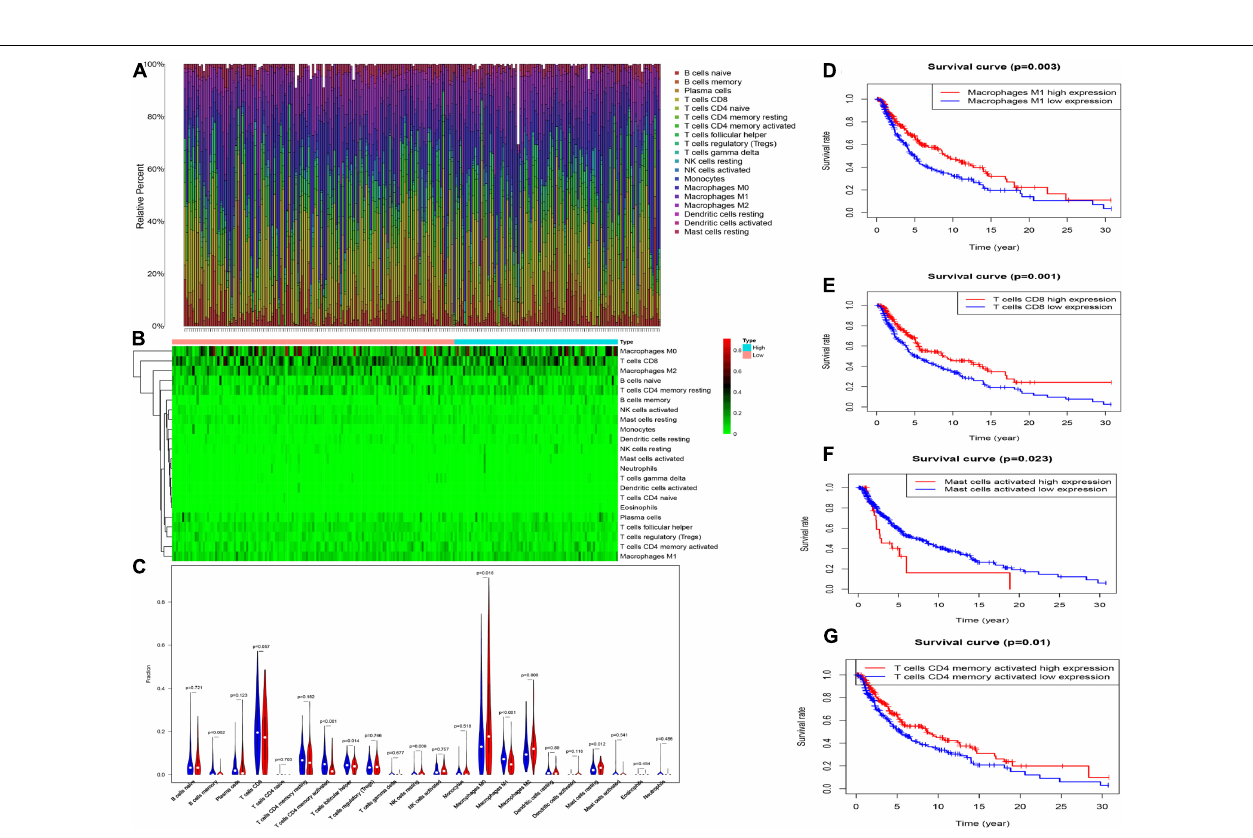
FIGURE 9 | The proportion (A) and heat map (B) of 22 immune cells in whole cohort. The comparison of the composition of immune cells between two risk group (low: blue vs. high: red) (C) . K–M curve between high and low level of infiltrating Macrophages M1, T cells CD8, and T cells CD4 memory activated (D–G) .